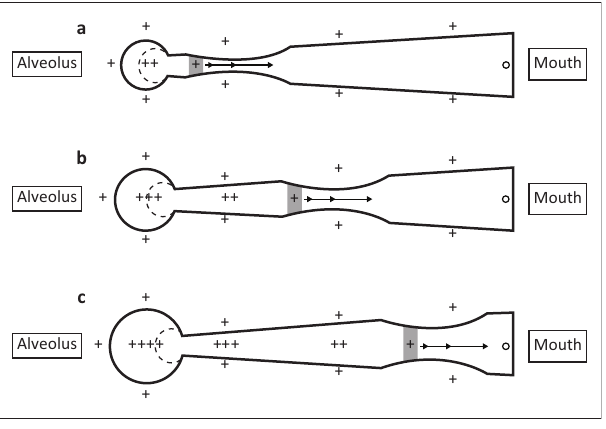
FIGURE 4: The equal pressure point during a forced expiratory technique at different lung volumes, (a) low volume, (b) mid volume and (c) high